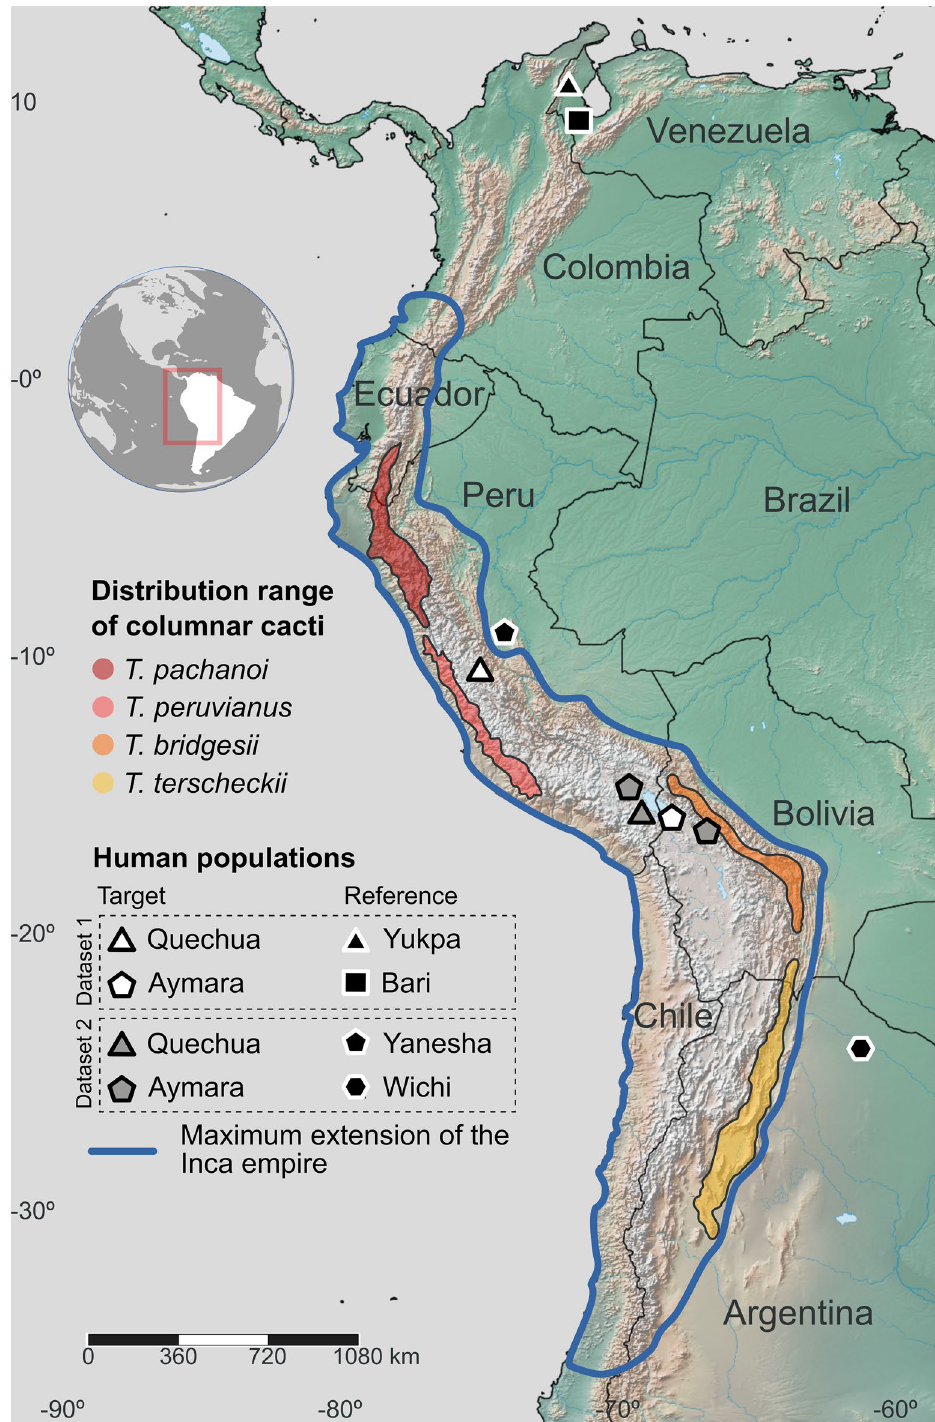
Figure 1. Location of Native South American populations used in this study along with the geographic range of the most representative hallucinogenic cacti of the genus Trichocereus . The maximum extent of the Inca Empire is depicted as an approximate reference of the shamanic area of influence using San Pedro cactus. The map was downloaded from Natural Earth (https:// www. natur alear thdata. com), licensed under Creative Commons Attribution 4.0 Unported license (http:// creat iveco mmons. org/ licen ses/ by/4. 0/) and the figure was edited with Inkscape 1.1 (http:// www. inksc ape.